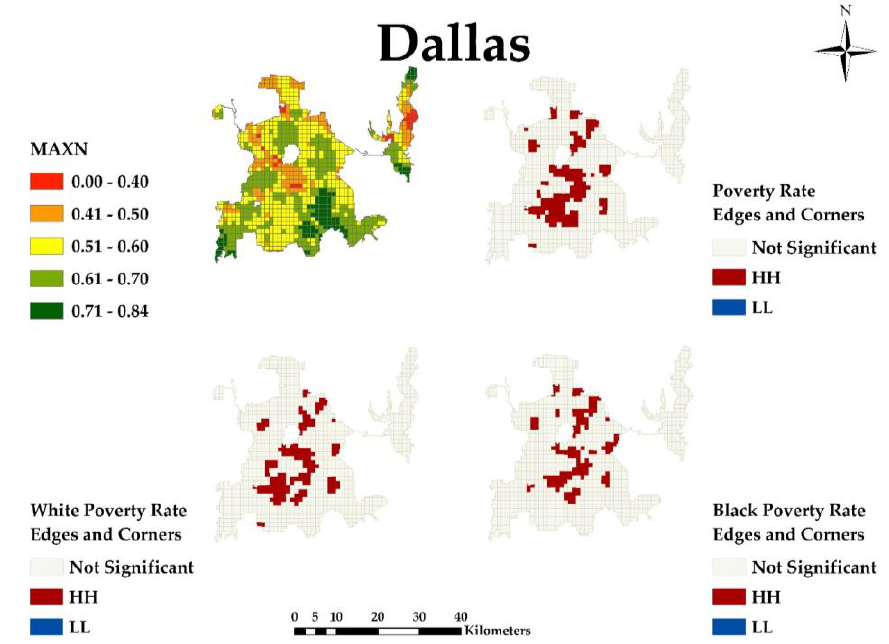
Figure 5. The LISA maps of Dallas growing city: MAXN, Poverty Rate, White Poverty Rate, and Black Poverty Rate.